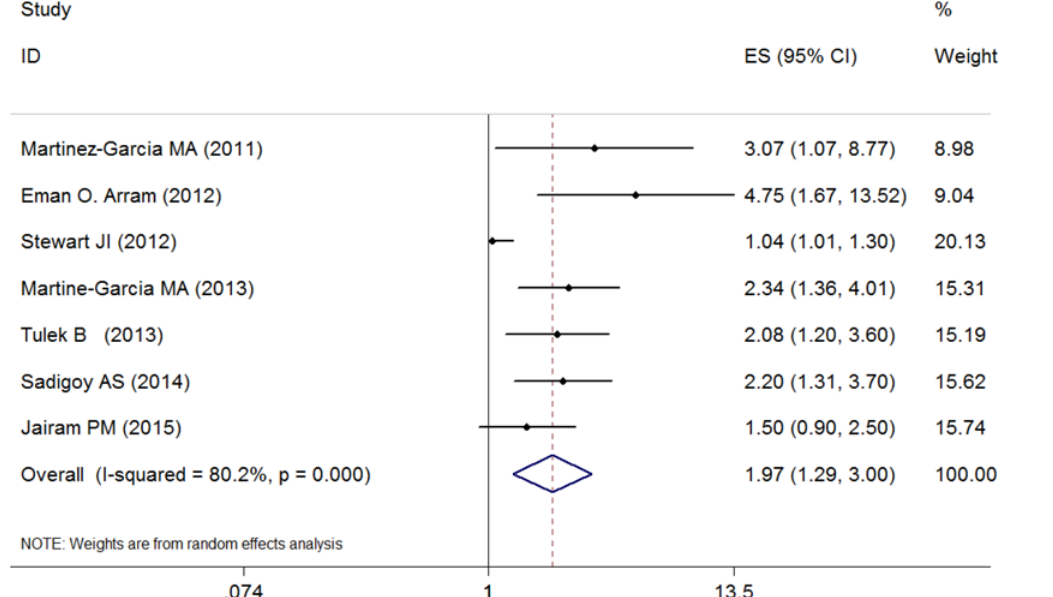
Fig 2. Odd ratios for the association between comorbid bronchiectasis and risk for COPD